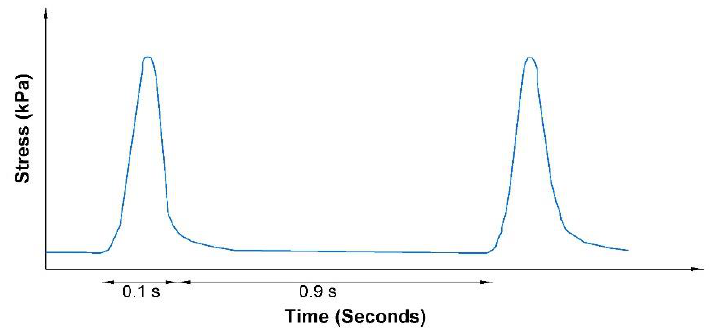
Figure 5. Loading form for Fn test.